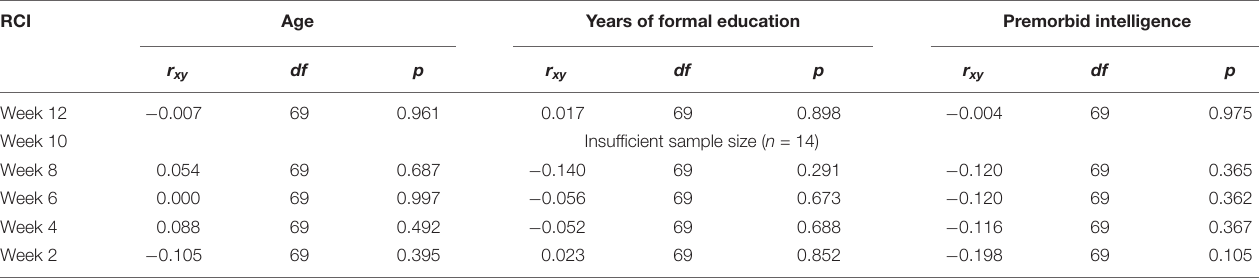
TABLE 5 | Mean, SD, bivariate analysis (ANOVA/ Kruskall Wallis test ), and homogeneity test of the RCI in all the weeks and the variable genetic polymorphism. RCI Poly. ¯ x ( SD ) Contrast df p Week 12 ( F = 3.830, p < 0.05) ∗ ss